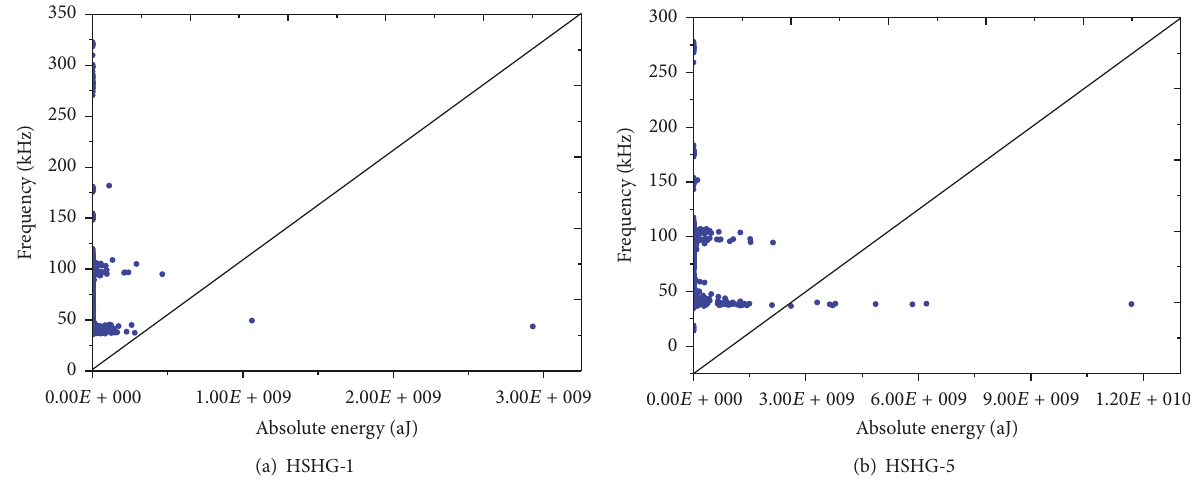
Figure 9: Acoustic emission energy during the granite rupture process dominate frequency scatter plot.